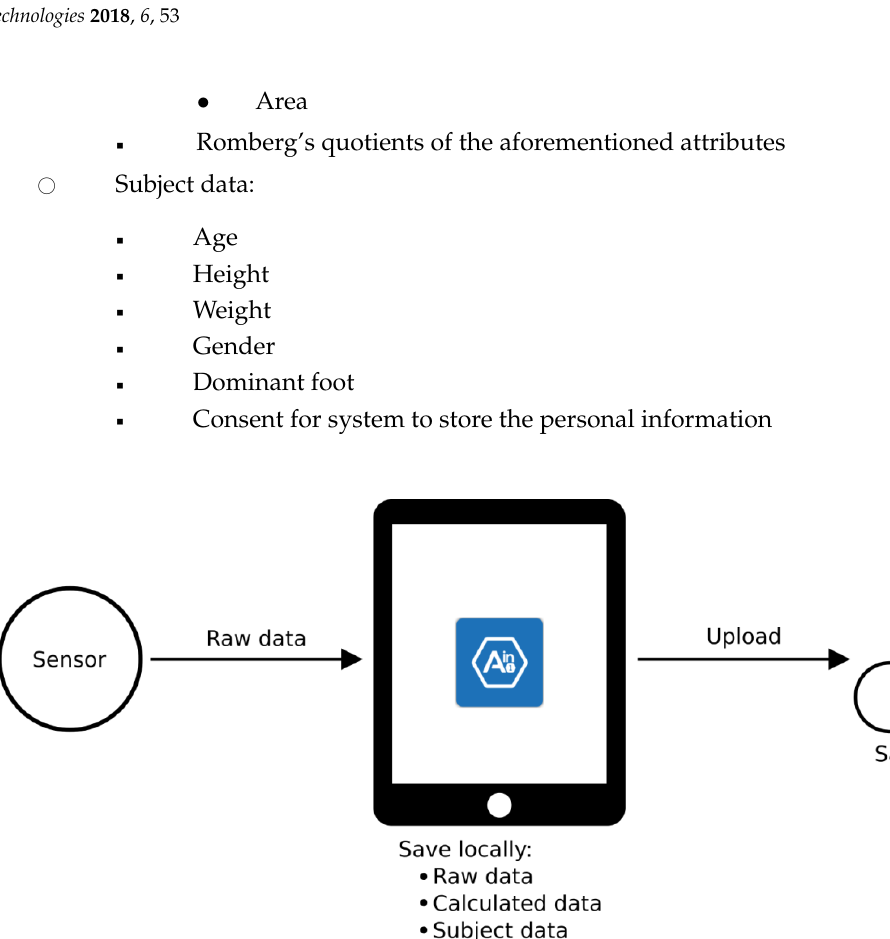
7 of 13 Figure 4. Screenshot of the software for the game prototype. 2.6. CES Demo Prototype All of the prototypes described above focus on testing functions of the end product. The CES demo prototype is a so-called alpha prototype, which is one step closer to the end product, in this case by having a specially designed user interface for the Android tablet. The name of the prototype came from an event called the CES (Consumer Electronics Show) [23], where the demo was presented alongside the hardware manufacturer. The target was to have first use and usability tests of the end product, in order to get feedback. Tests were completed by the authors to see how different parts of the user interface worked in action while showing the demo at the CES. Therefore, this prototype didn’t have a back end to connect to, and did not save the data on the device or in the cloud. The CES prototype also tested how the complete integration of the sensor, tablet, application, and algorithms worked. The application calculated the path length of the sway of the subject, the standard deviation of the sway velocity and the sway area, and the Romberg’s quotients of the aforementioned attributes of two sequential measurements. The CES demo prototype’s hardware, software, and data elements were:  Hardware: o 9.7” Samsung Galaxy S3 tablet with Android 7 (Nougat) o